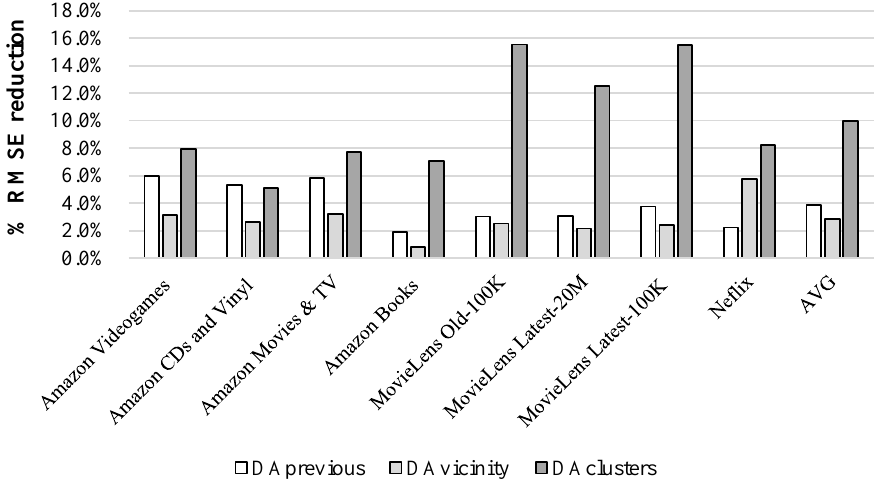
Figure 2. RMSE improvement achieved by the DA